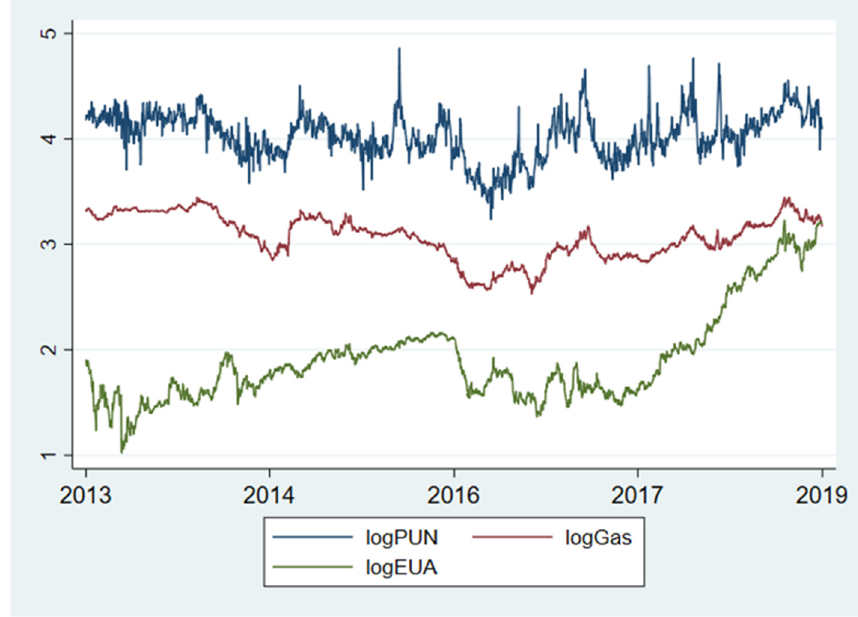
Figure A1. Graphical representation of electricity (PUN), allowances and gas prices. Table A1. Summary statistics.